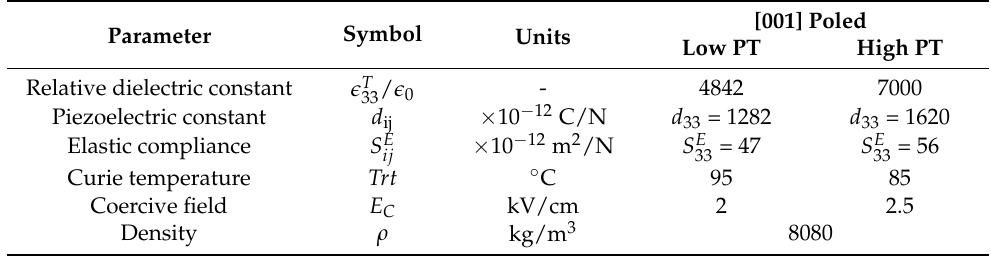
Table 3. Material properties of PMN-PT piezoelectric single crystals [25]. (Copyright granted by iBULe Photonics Inc., Incheon, Republic of